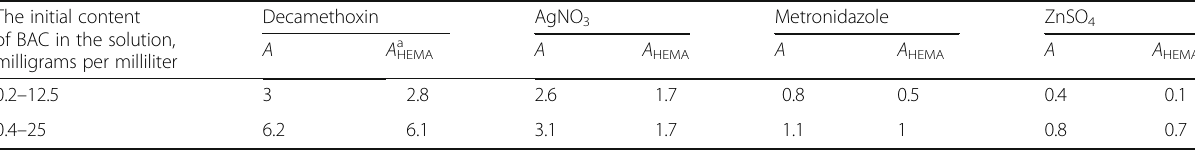
Table 3 Effect of HEMA on BAC adsorption ( A , mmol/g) on nanosilica surface The initial content of BAC in the solution, milligrams per